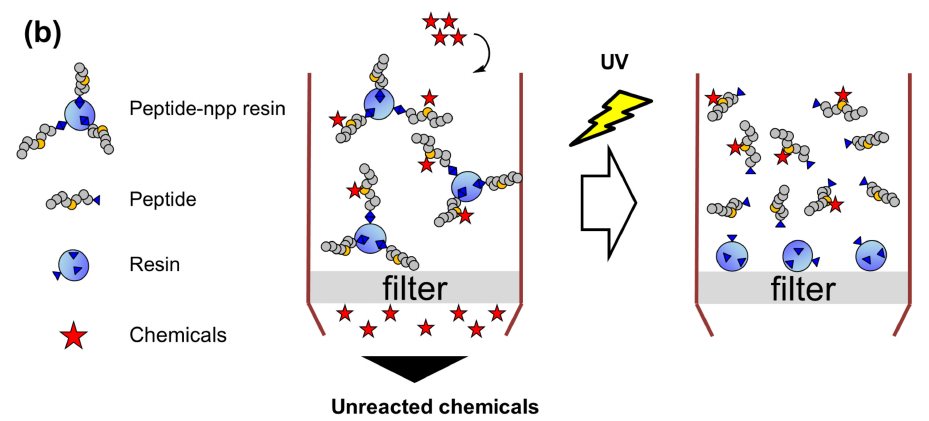
Figure 1. Outline of this study. ( a ) Structures of cysteine (Cys) or lysine (Lys)-peptide-npp resin. ( b ) Schematics showing the filtration of the unreacted compounds using a column and assessment of skin sensitization using a photo-cleavable linker and solid phase-immobilized